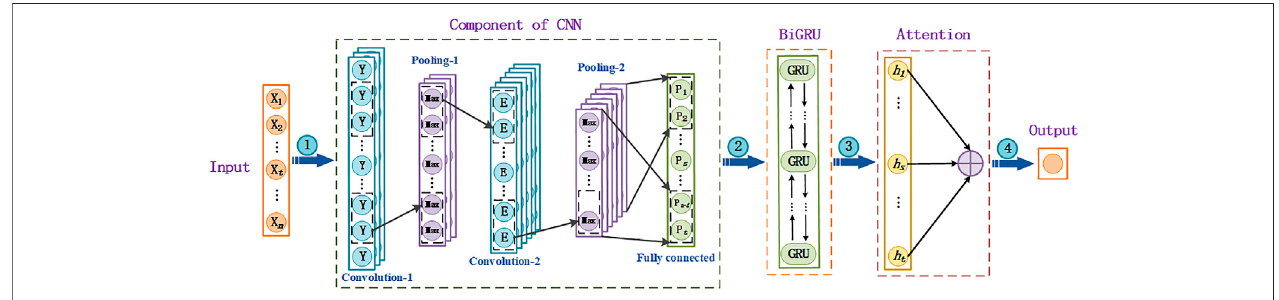
FIGURE 1 | CNN-BiGRU model structure based on Attention mechanism.